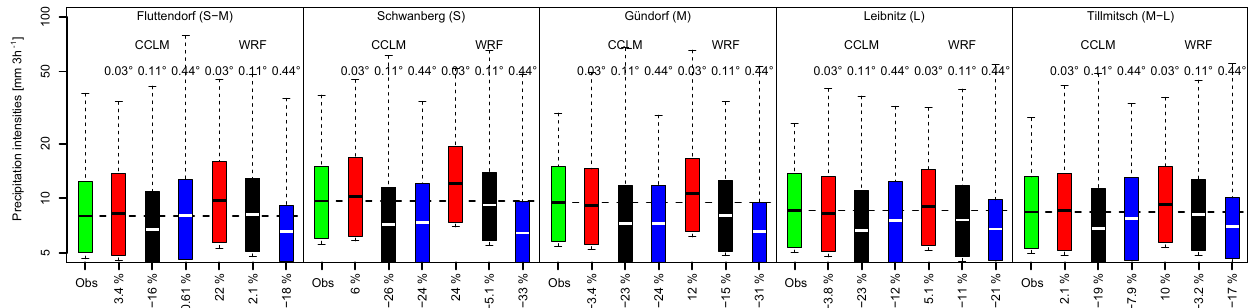
Figure 5. Catchment-averaged heavy ( > 90th percentile) precipitation intensities of observations (green) and CCLM and WRF with 0.03 ◦ (3km; red), 0.11 ◦ (12.5km; black) and 0.44 ◦ (50km; blue) grid spacing. Y axis has a logarithmic scale. Coloured boxes indicate the 10th– 90th inter-quantile range, horizontal markers in the boxes denote mean values and whiskers refer to maximum values. Relative biases of mean values are given along the x